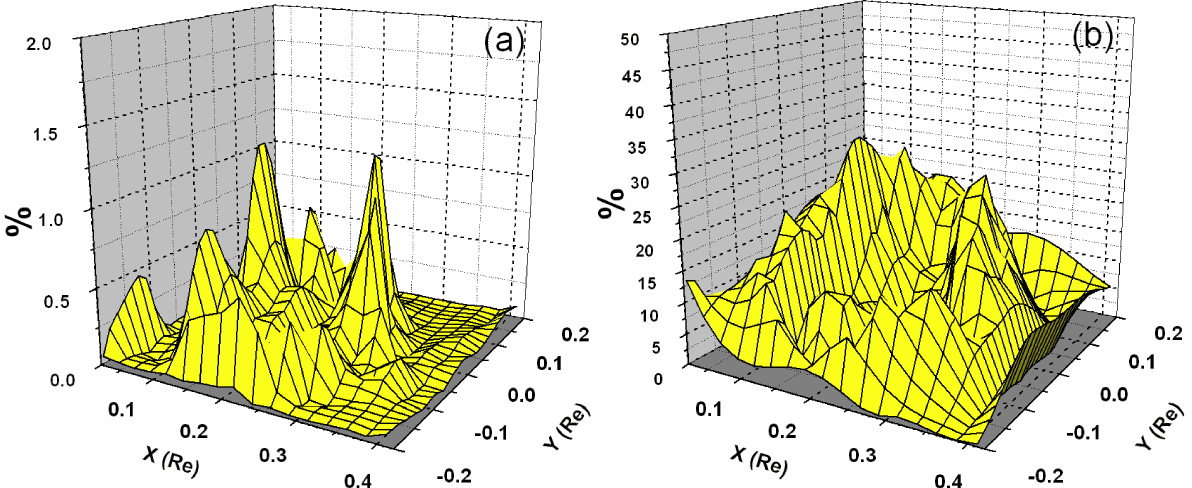
Fig. 3. The distribution of the discrepancy between the recovered B z and B z from G-S technique in the x-y plane: (a) for the recovered B z from FFT, (b) for the recovered B z from 2-D polynomial